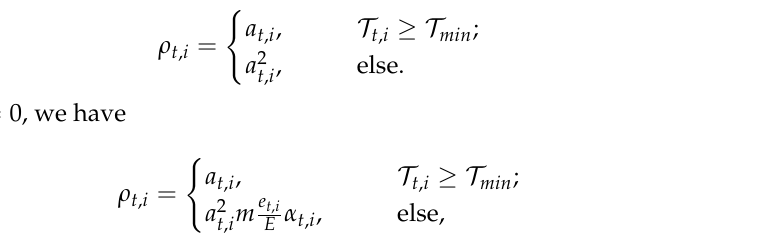
Algorithm 1 finds the optimal policy for the time and energy management by